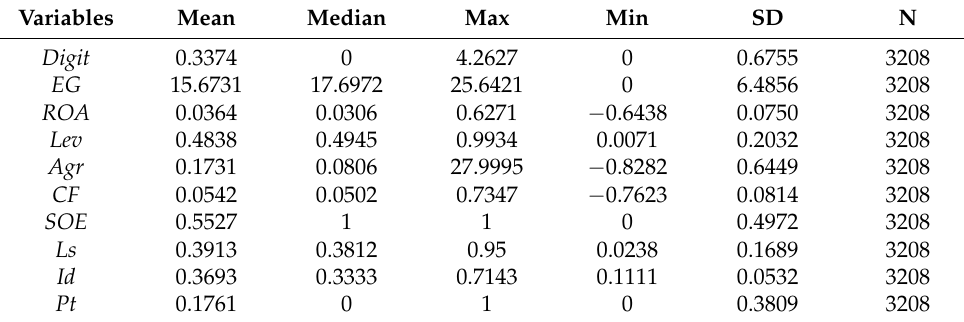
Table 2. Descriptive statistics of the main